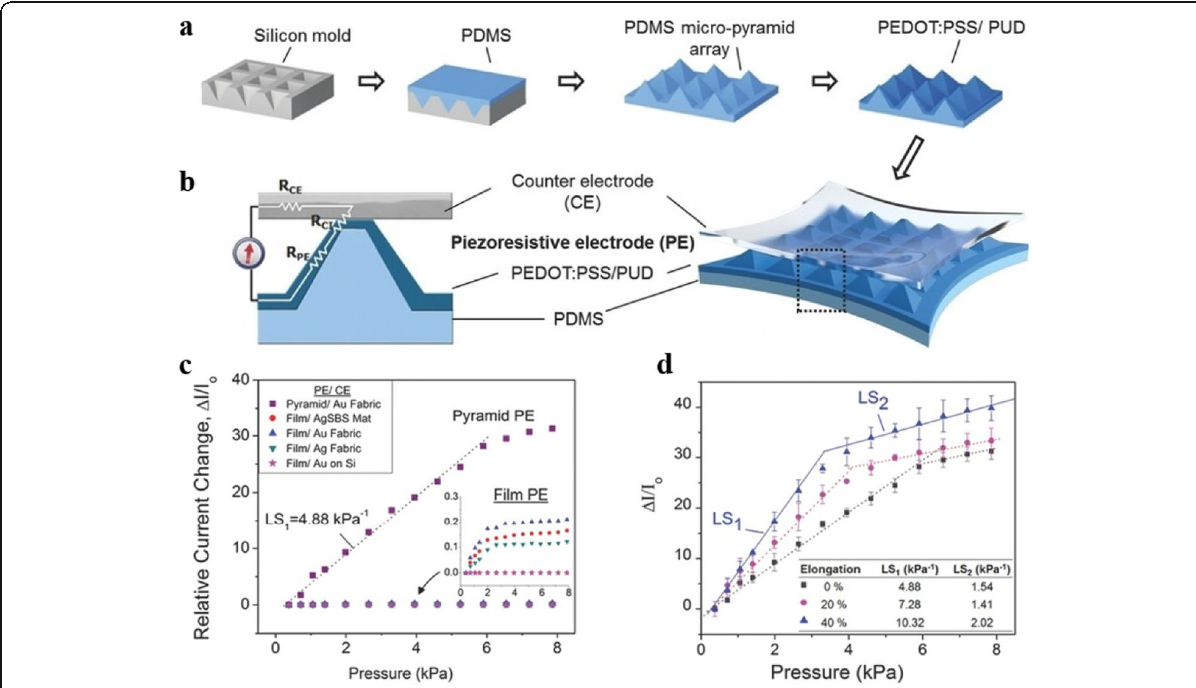
Fig. 2 a Fabrication process of micropyramid PDMS array. b Schematic of sensing principle of the sensor with micropyramid structure under external force. c Improved sensitivity of pyramid sensors compared with unstructured sensors. d Linear pressure responses of micropyramid sensors when stretched. Adapted with permission from ref. 10. Copyright 2014 John Wiley and